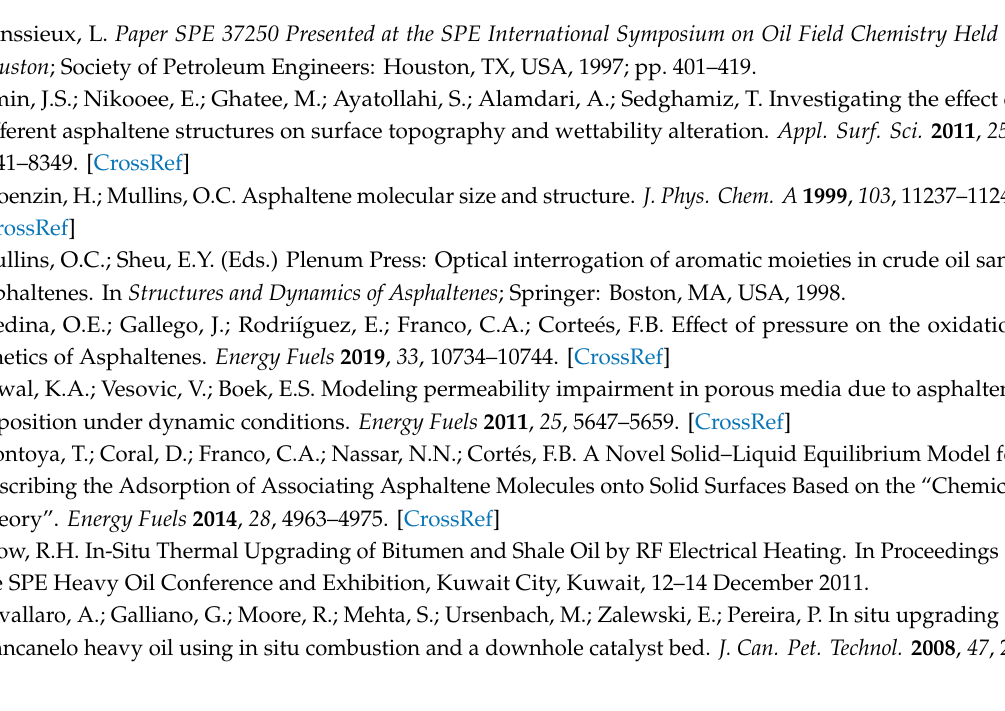
Figure S1: Simplex–centroid mixture design with (a) fumed silica (SiO 2 ), iron oxide (Fe), and molybdenum oxide (Mo); and (b) fumed silica (SiO 2 ), nickel oxide (Ni), and molybdenum oxide (Mo). Table S1: Parameters of the surface area design for Si-Fe-Mo. Table S2: Parameters of the surface area design for Si-Ni-Mo. Figure S2: Response surface to surface area of design with (a) Si-Fe-Mo and (b) Si-Ni-Mo. Table S3: Parameters of the surface area design for Si-Fe-Ni-Mo. Table S4: Estimated SLE model parameters for SiO 2 and functionalized nanoparticles with elements transition. Figure S3: H values from SLE model for silica and functionalized nanoparticles. Table S5: Coe ffi cients to activation energy mixture design for Si-Ni-Mo. Figure S4: Trace plot for activation energy for the series (a) Si-Ni-Mo and (b) Si-Fe-Mo. Table S6: Coe ffi cients to activation energy mixture design for Si-Fe-Mo. Table S7: Coe ffi cients to activation energy mixture design for